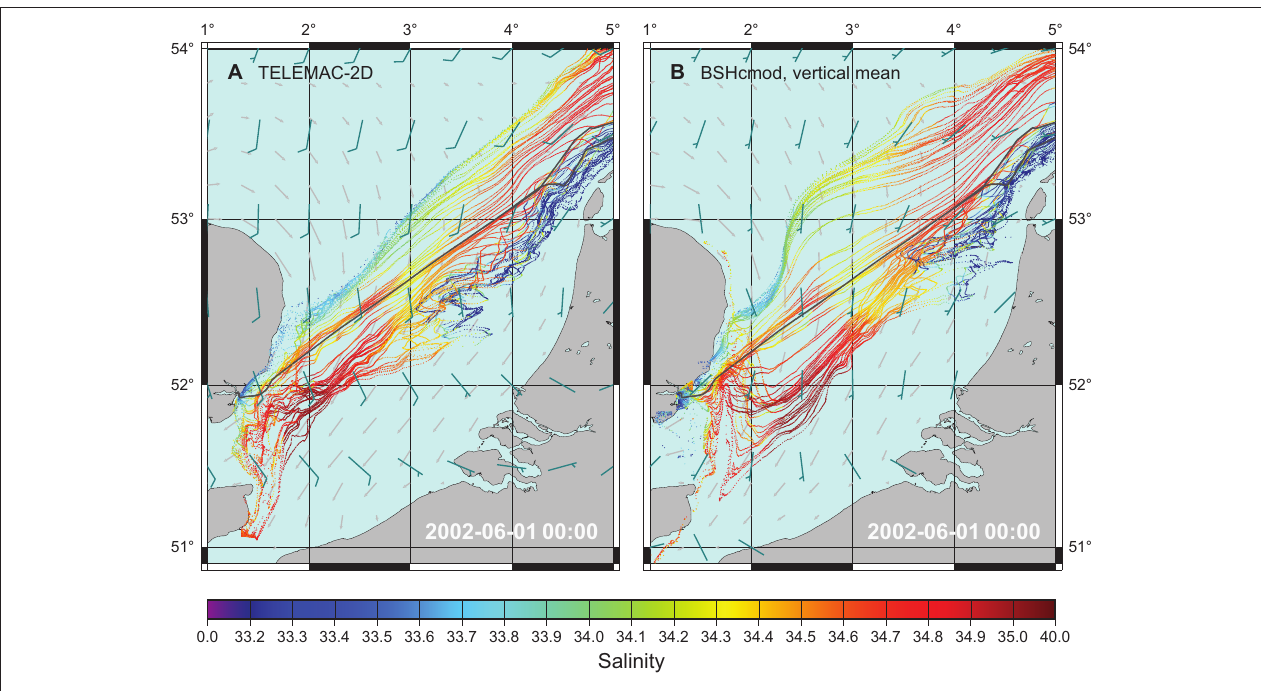
FIGURE 10 | (A) Zooming into the western part of Figure 5 . Simulations were performed based on TELEMAC-2D simulations. (B) Same setup, except that drift simulations are now based on vertical mean currents from the operational 3D model BSHcmod. An animation of this figure is provided as a Supplementary Video 2 .